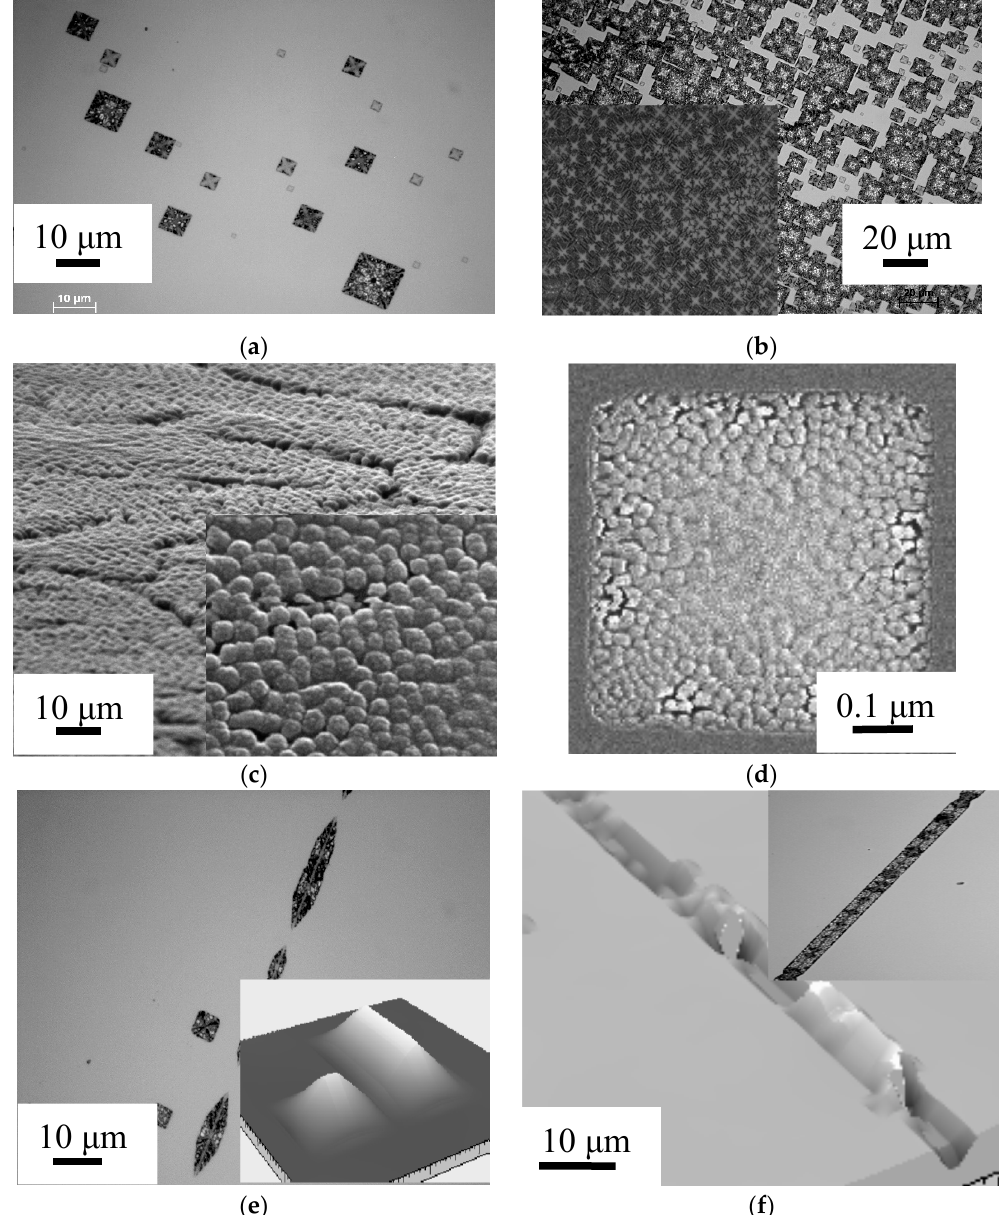
Figure 1. Micrographs (a,b,e,f—light microscopy; c,d—ion (He) microscopy) of 3C-SiC(100) layer surface at the different growth stages: ( a ) nucleation of the separate islands on the carbonized Si surface; ( b ) multiple coalescence of islands with conservation of island morphology (insert—thick continuous layer); ( c ) thick continuous layer with the large-block structure (insert—grain structure of the separate block); ( d ) separate island with the grain structure; ( e,f ) optical microscopy images of the dotted ( e ) and linear (( f )—along the line of the crystalline plane slippage) morphological formations on the surface of 3C-SiC/Si(100) heterostructures.